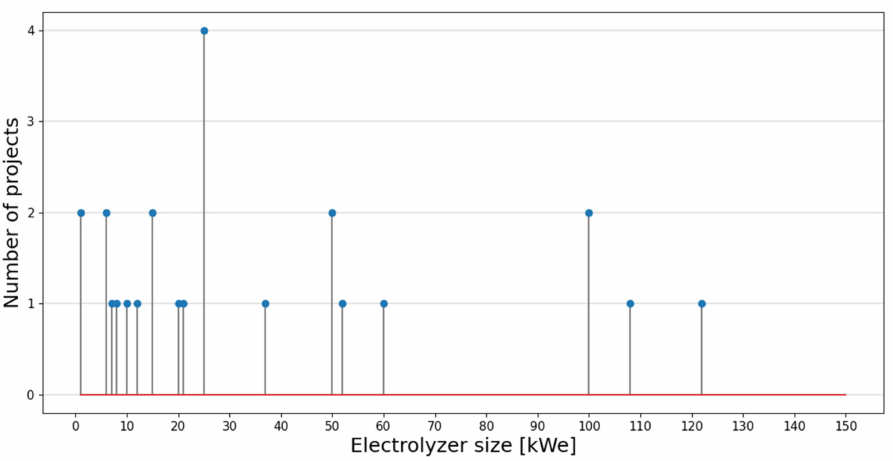
Figure 4. Number of power-to-gas projects per electrolyzer size (focused on smaller